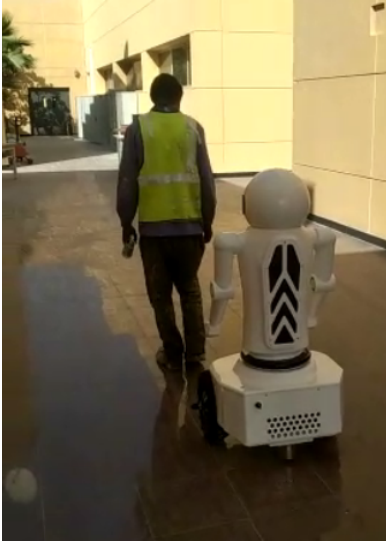
Figure 30. Outdoor following